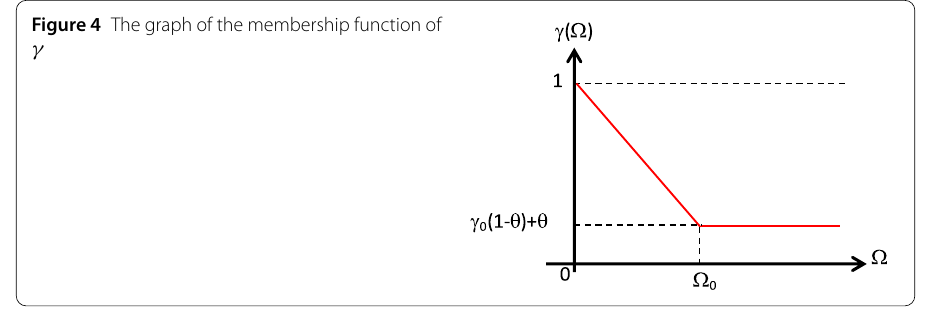
Figure 4 The graph of the membership function of